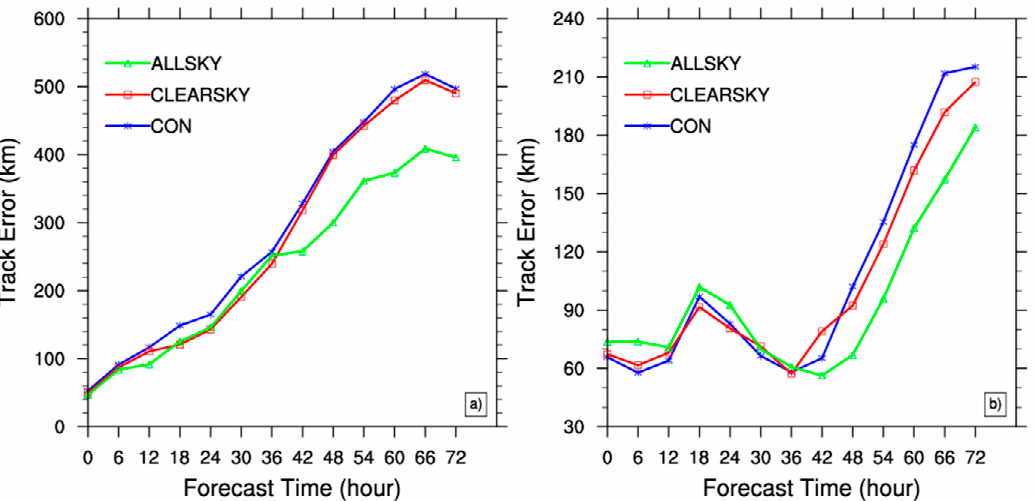
Figure 5. The averaged absolute track errors against JTWC best tracks from the three experiments for ( a ) Chan-hom and ( b ) Nangka.